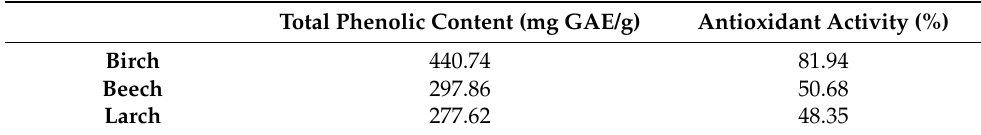
Table 1. Total phenolic content in GAE/g and antioxidant activity of sterile-filtered bark